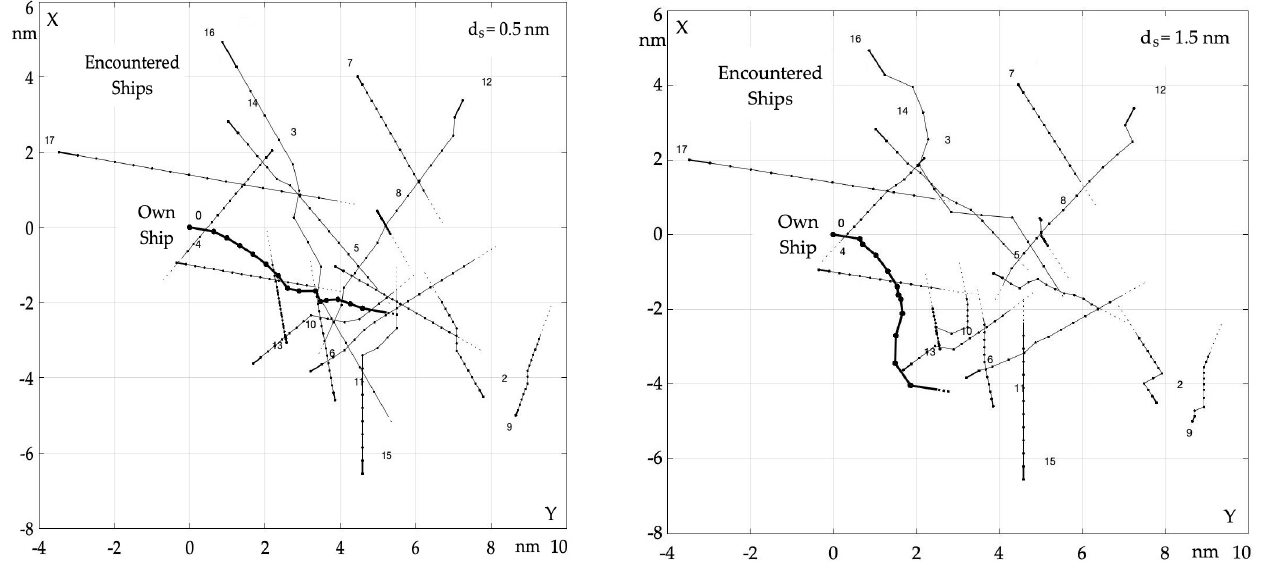
Figure 10. Autonomous surface ship safe path when passing K = 17 encountered autonomous surface ships in good ( d s = 0.5 nm) and restricted ( d s = 1.5 nm) visibility at sea, determined by MG_c algorithm of cooperative matrix game.